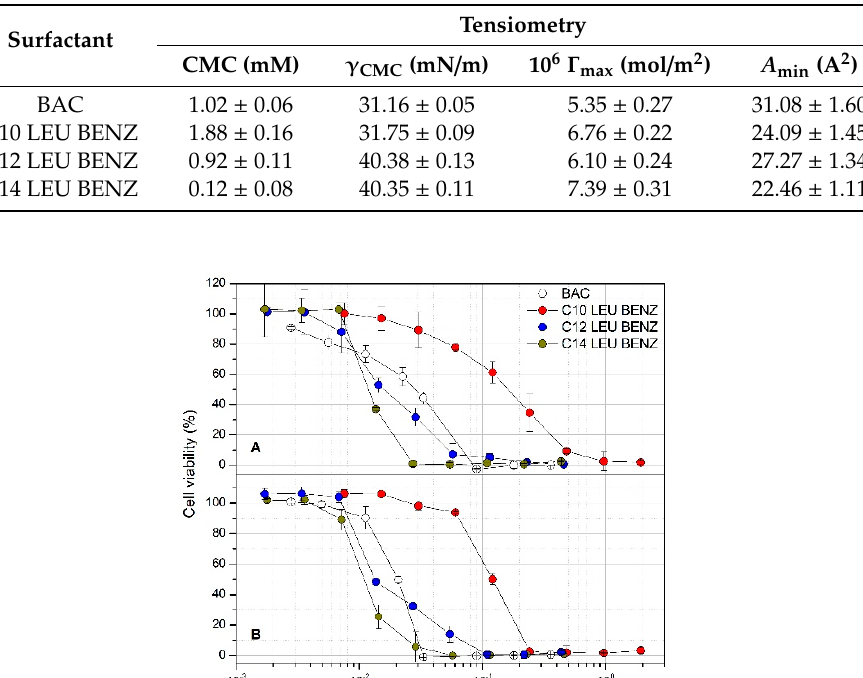
Figure 2. Cell viability (%) of Caco-2 (intestinal epithelial) ( A ) and Calu-3 (airway epithelial) ( B ) cell lines after exposure to different concentrations of the quaternary ammonium leucine surfactants (C10 LEU BENZ, C12 LEU BENZ and C14 LEU BENZ) and the reference compound BAC. Dots represent the mean and bars the standard error ( n = 4).